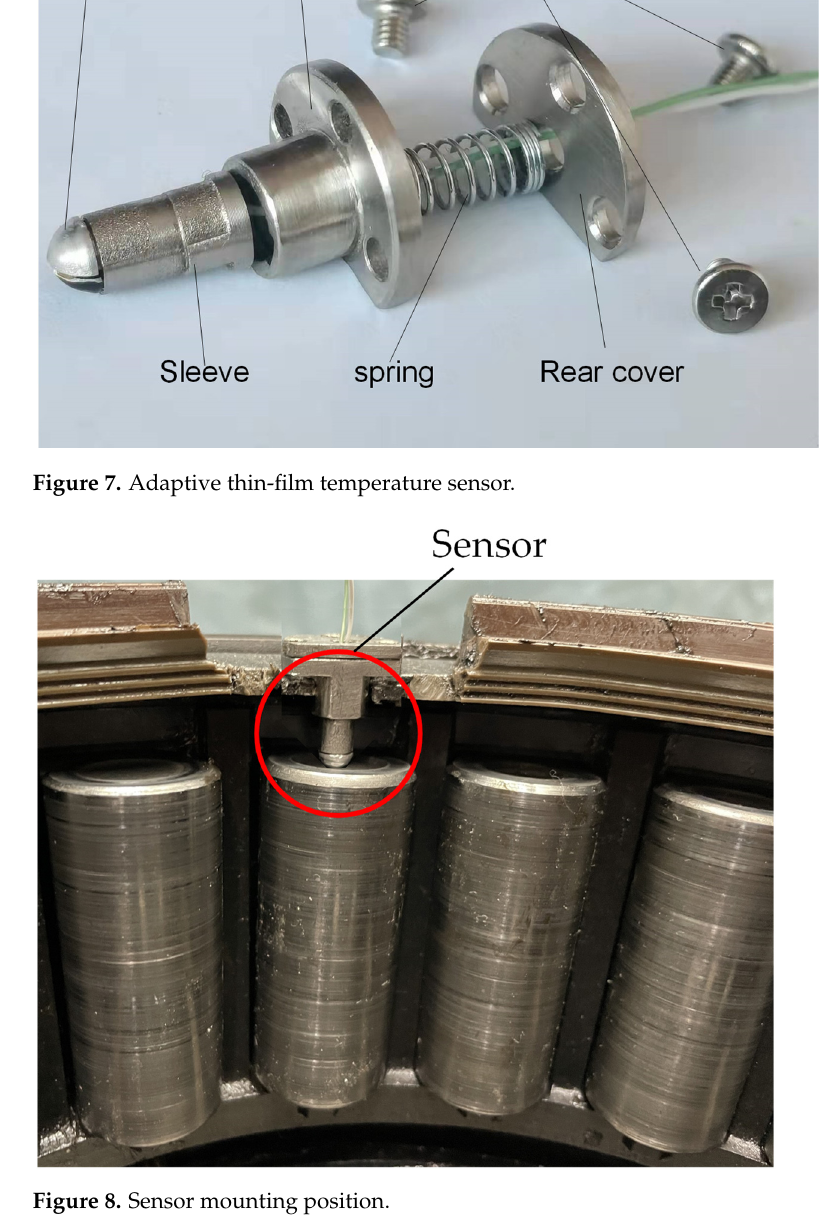
( b ) Figure 9. Location of temperature measuring point of railway bearing: ( a ) circumferential tempera- ture measuring point; ( b ) axial temperature measuring point of outer ring. When the bearing is running, the outer ring is fixed, and the temperature of the outer ring temperature measuring point can be measured directly by the infrared temperature measuring gun. We obtained the average roller temperature by using the self-developed adaptive thin-film temperature sensor. We fixed the infrared temperature measuring gun on the test bench, adjusted the angle to align it with the outer surface of the inner ring